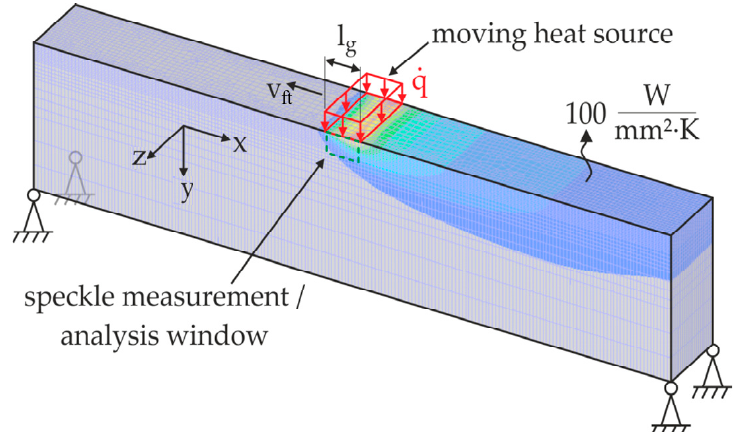
Figure 1. Schematic of the used model, boundary conditions, mesh and the temperature distribution